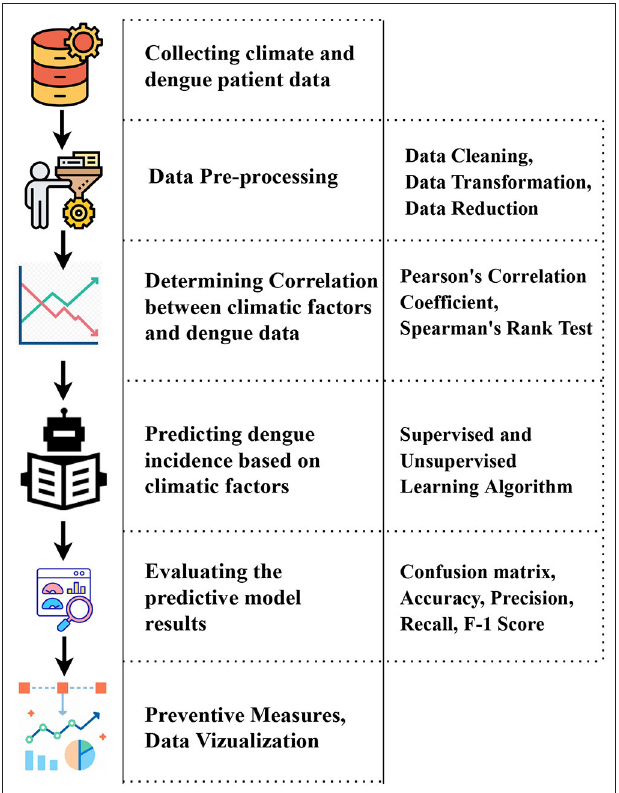
FIGURE 8 | Process of developing a dengue surveillance